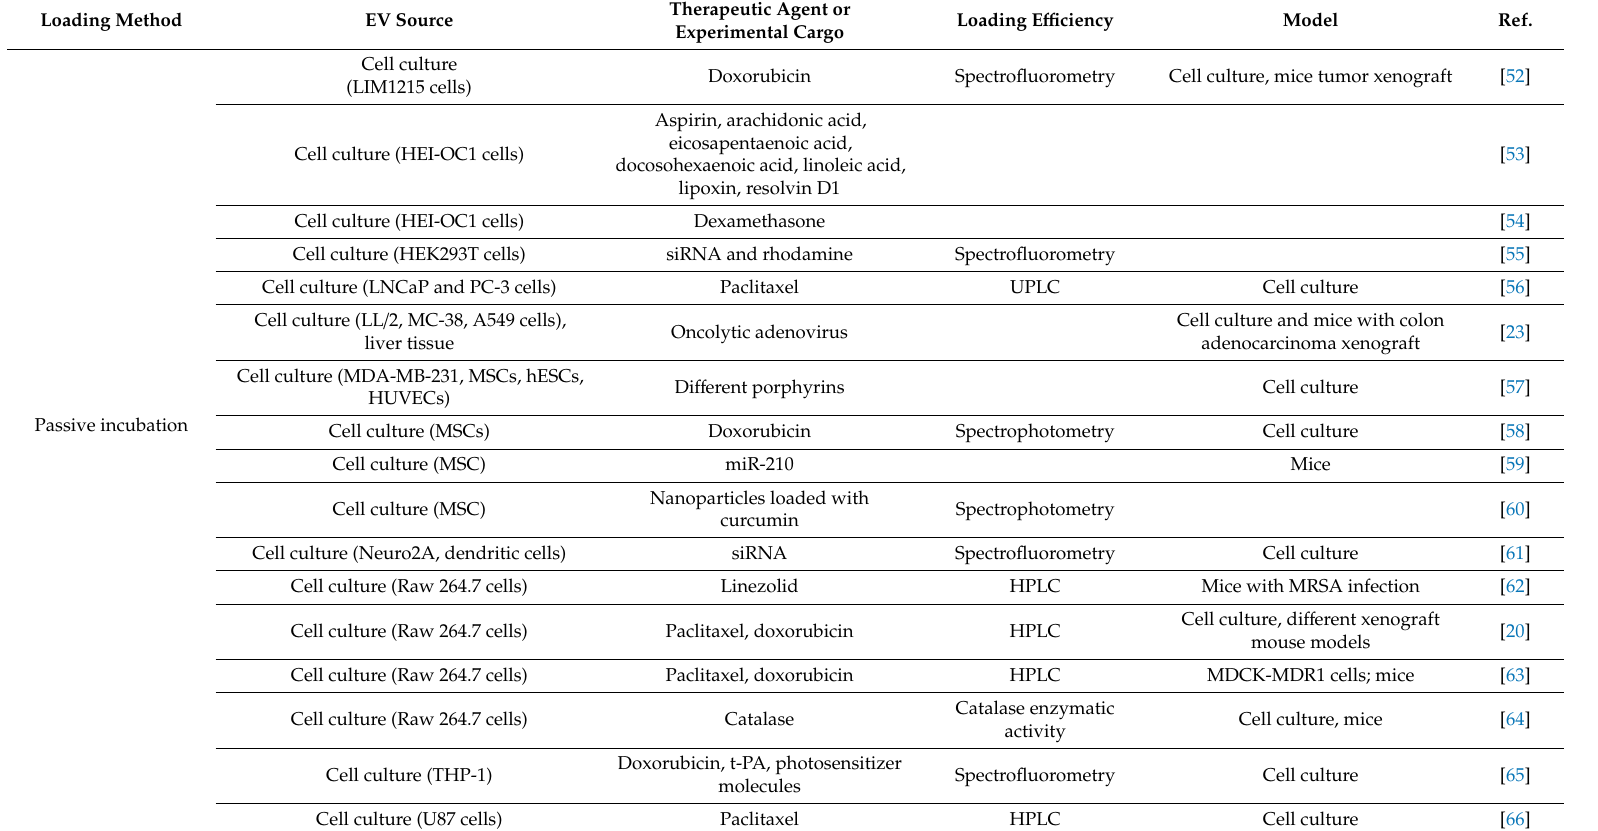
Table 1. Strategies for the loading of EVs with therapeutic agents. Detailed are di ff erent studies describing the loading of EVs with therapeutic agents. The specific loading method, the source of EVs as well as the therapeutic agent or experimental cargo are mentioned. Subsequently, the method used to evaluate the loading e ffi ciency, if known, is indicated. Finally, the model where the generated EVs were applied is indicated. Abbreviations: DNA-CH: cholesterol-coupled DNA; dsDNA: double stranded DNA; EXPLORs: exosomes for protein loading via optically reversible protein-protein interactions; hESC: human embrionary stem cell;